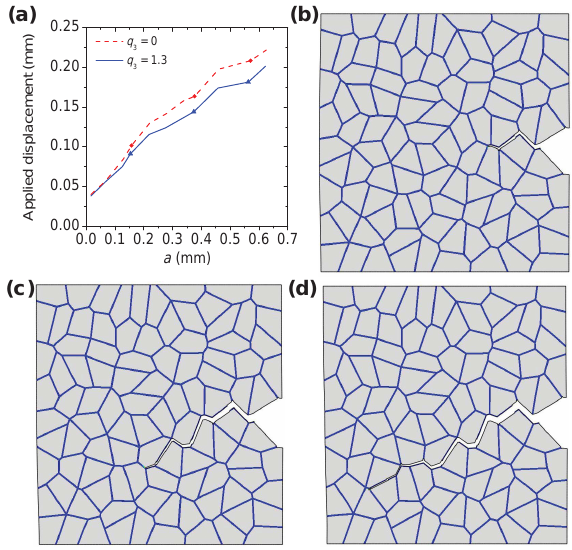
Figure 15. The crack propagation process in a notched-tensile specimen: ( a ) the applied displacement versus the crack length a curves at n 1 = 0.12. Contour plots in ( b – d ) show the moment corresponding to the different crack lengths indicated in ( a ).